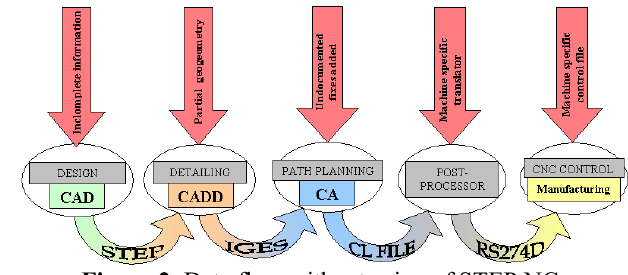
Figure 2. Data flow without using of STEP